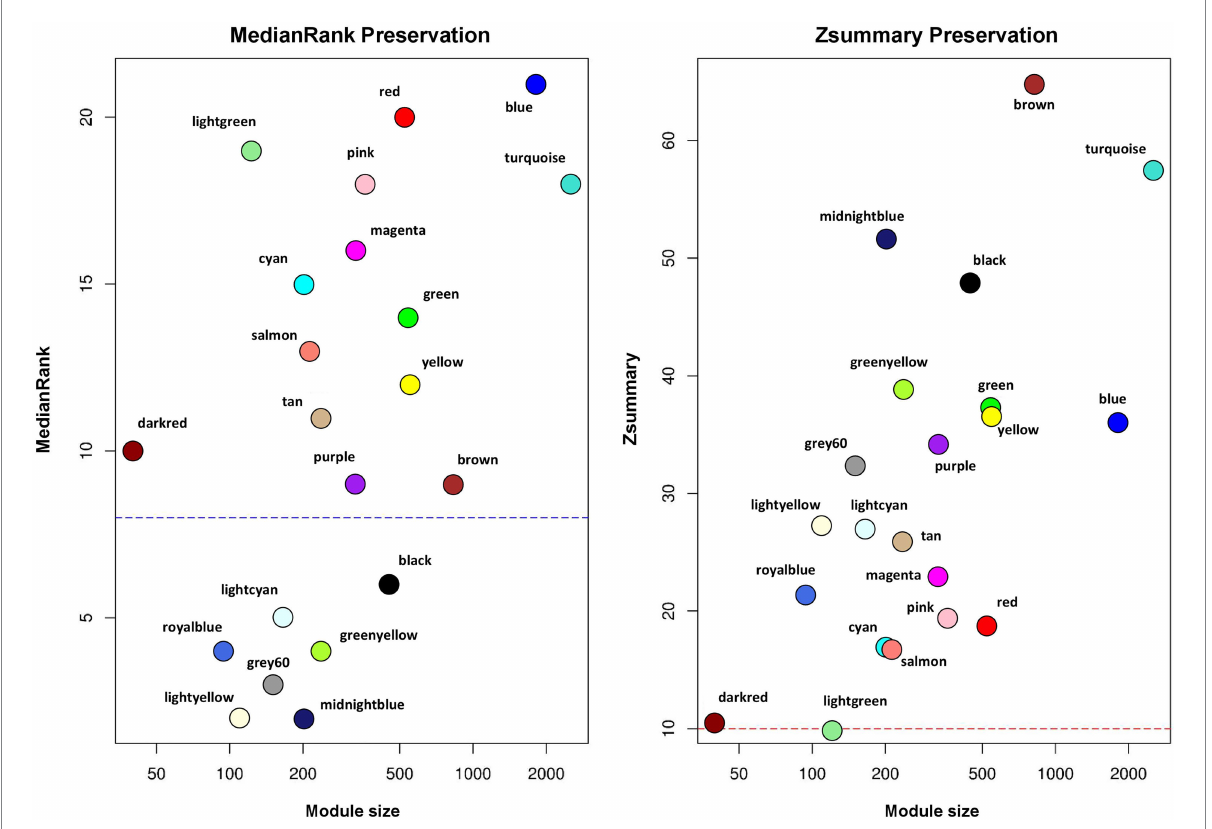
FIGURE 5 Module preservation analysis. (A) The medianRank preservation statistics. The y -axis represents medianRank values for different modules and the x -axis represents module size. Each point indicates a module labeled by a unique color. The blue dashed line represents the medianRank threshold. (B) The Z summary preservation statistics. The y -axis represents Z summary values for different modules and the x -axis represents module size. Each point indicates a module labeled by a unique color. The red dashed line represents the Z summary threshold. Modules with Z summary ≤ 10 or medianRank ≥8 were considered as non-preserved between non-infected control and Mycobacterium bovis -infected